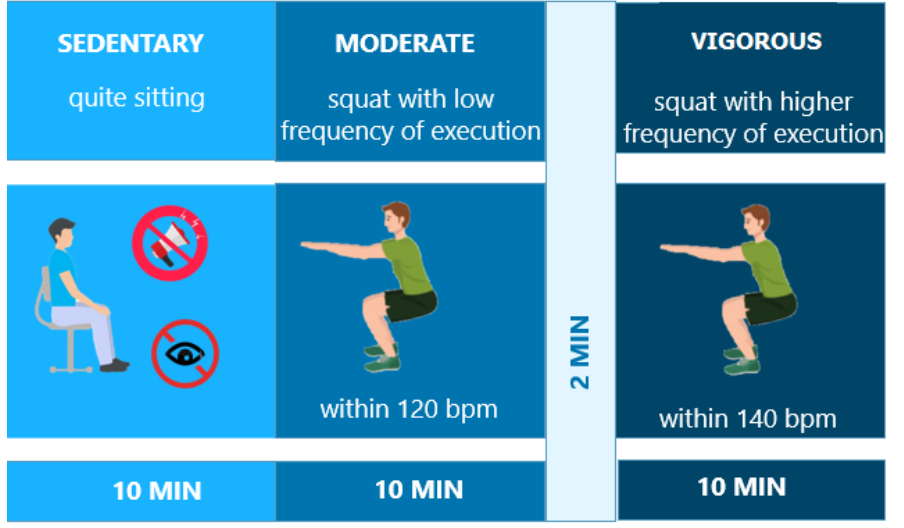
Figure 2. Time arrangement of the PA experimental